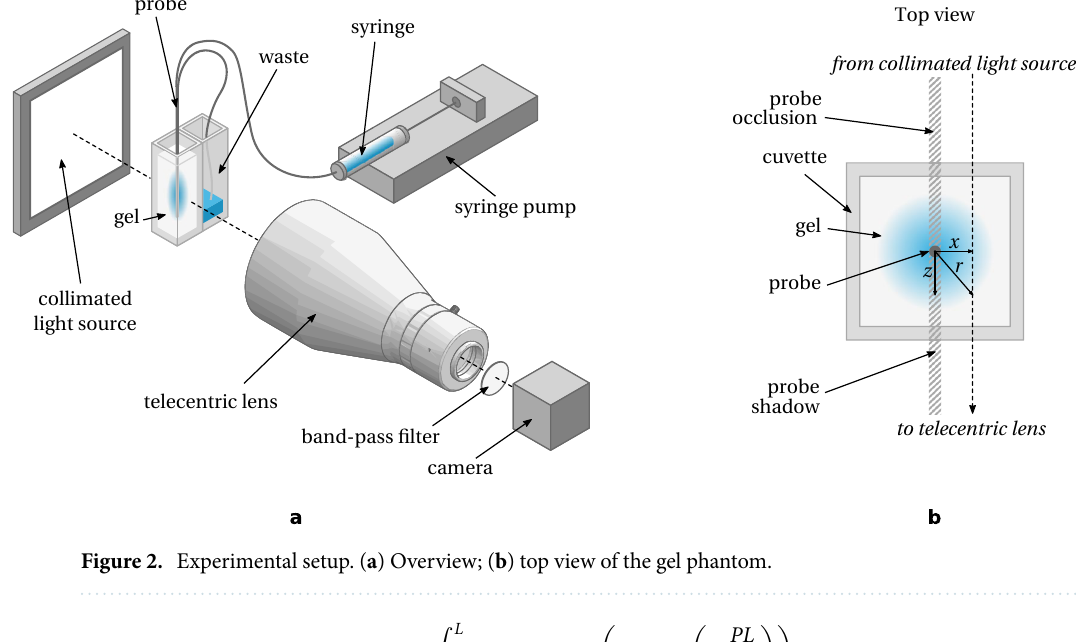
Figure 2. Experimental setup. ( a ) Overview; ( b ) top view of the gel